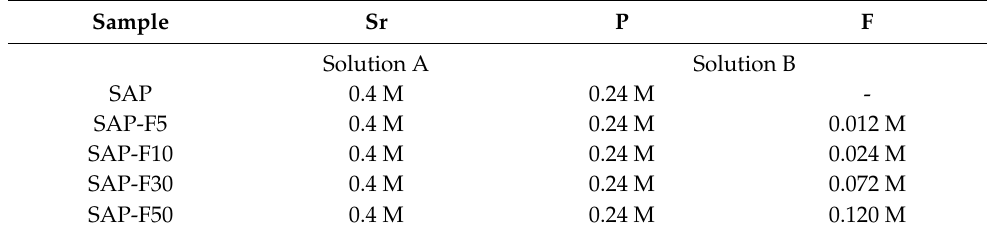
Table 1. Additive amounts of the synthesized